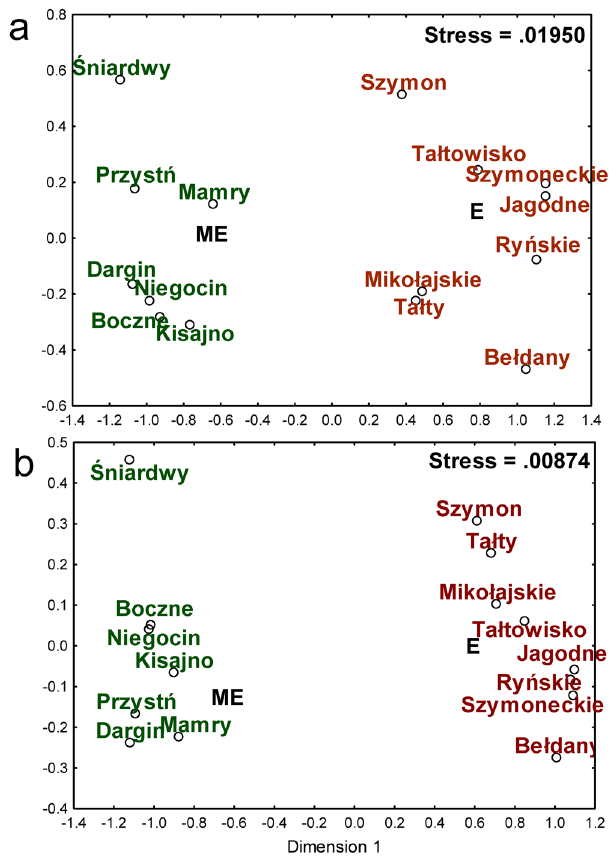
Figure 3. ( a ) The graphical results of the Bray-Curtis-based NMDS analysis of sequence data, binned by taxonomic assignment to family. The whole domain Bacteria was taken into consideration. The lakes marked in red are eutrophic (E), and lakes marked in green are meso-eutrophic (ME). ( b ) The graphical results of the Bray- Curtis-based NMDS analysis of sequence data, binned by taxonomic assignment to family, after excluding 25 families belonging to phylum Cyanobacteria from the analysis. The lakes marked in red are eutrophic (E), and lakes marked in green are meso-eutrophic